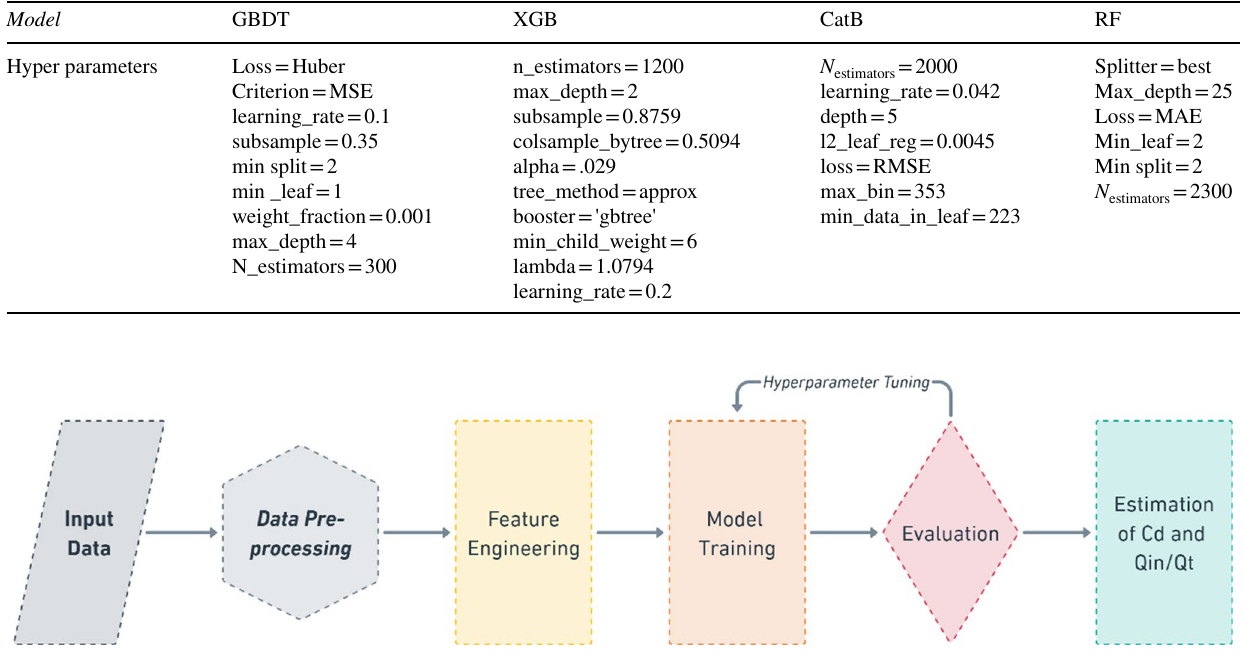
Fig. 7 model training workflow